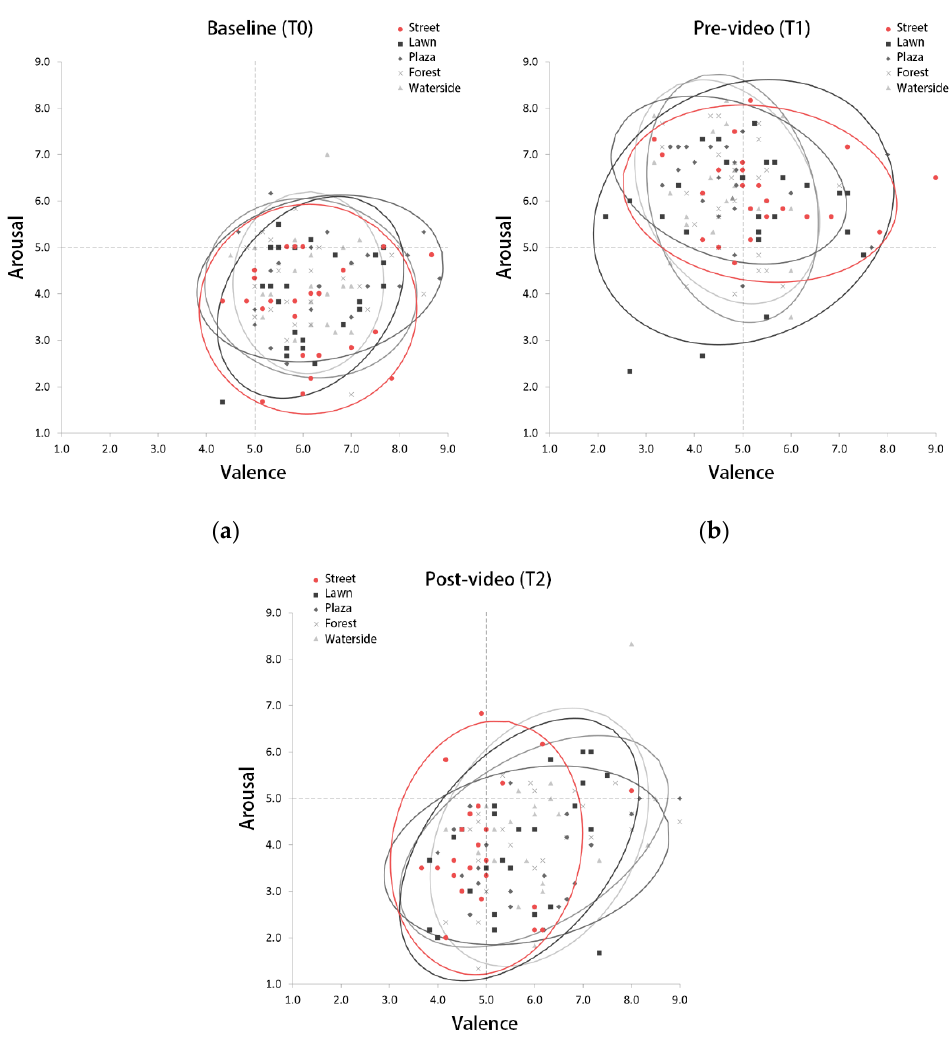
Figure 5. Scatter plots of total emotion (Valence-Arousal) for different groups at baseline ( a ), pre-video ( b ), and post-video ( c